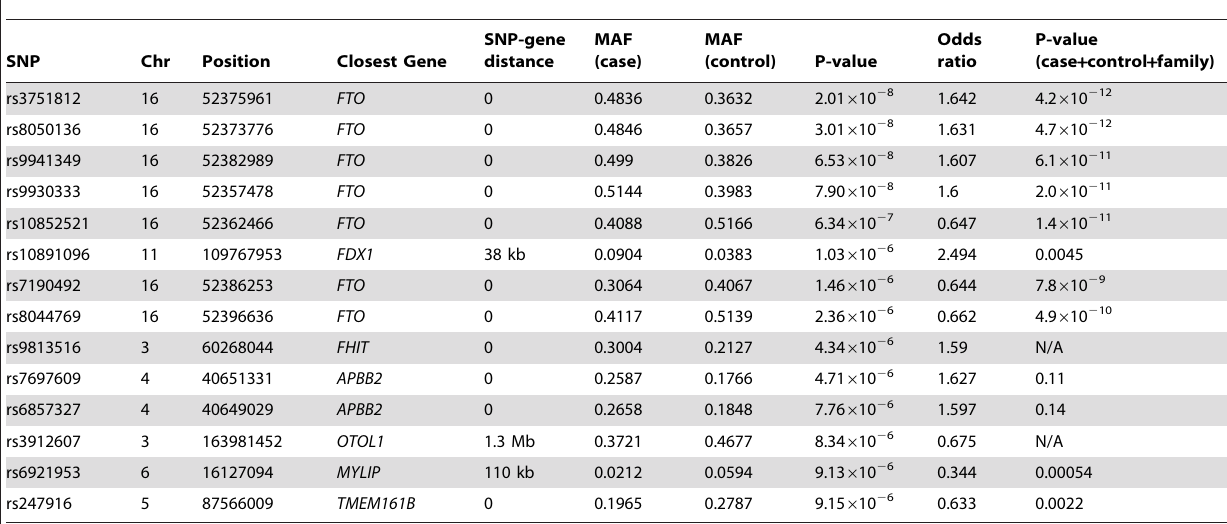
Table 3. Top association results (P , 5 6 10 2 8 ) for GWAS on